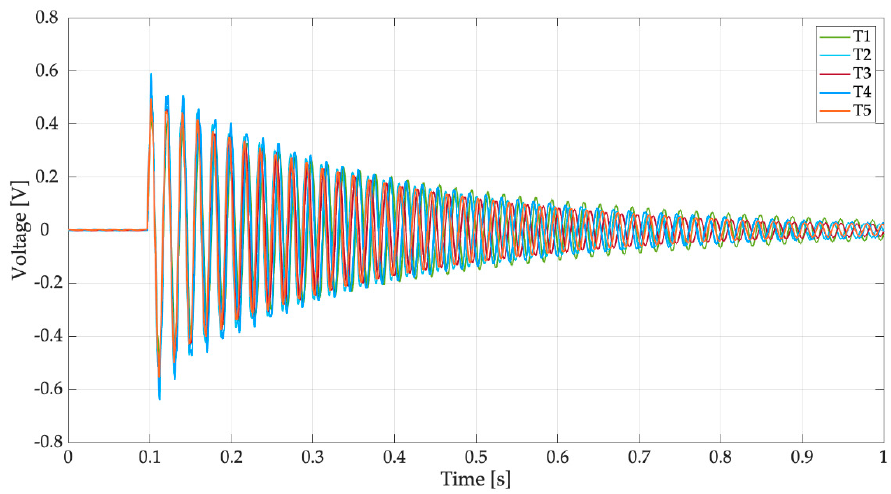
Figure 13. Tests with drops falling from 1 m on the empty spoon, open-circuit voltage.